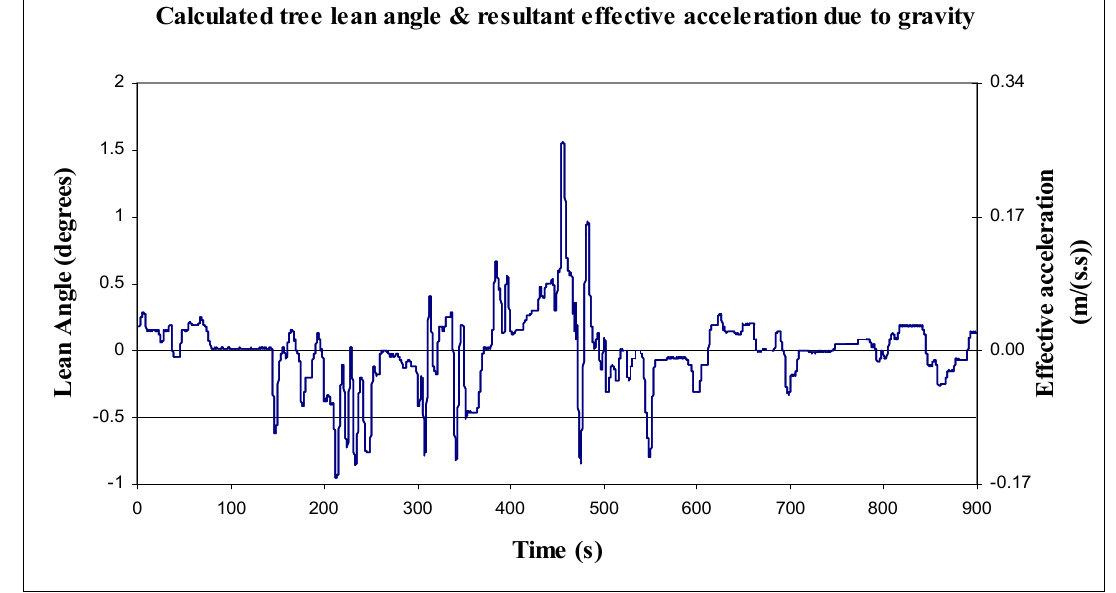
Figure 8. Calculated Lean Angle and resultant effective